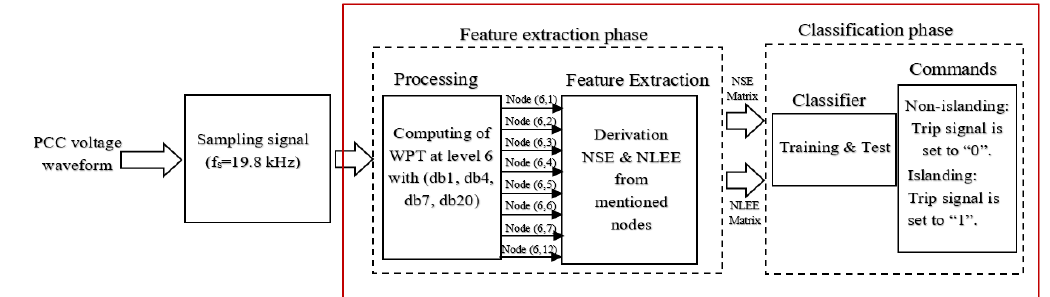
Figure 8. The block diagram of the proposed islanding detection scheme.